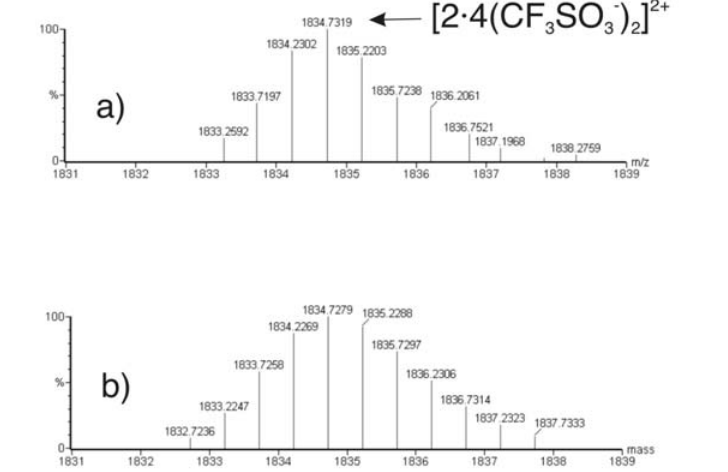
SO ) 2- ] 2+ . a) Observed isotopic distribution. b) Calculated isotopic 3 3